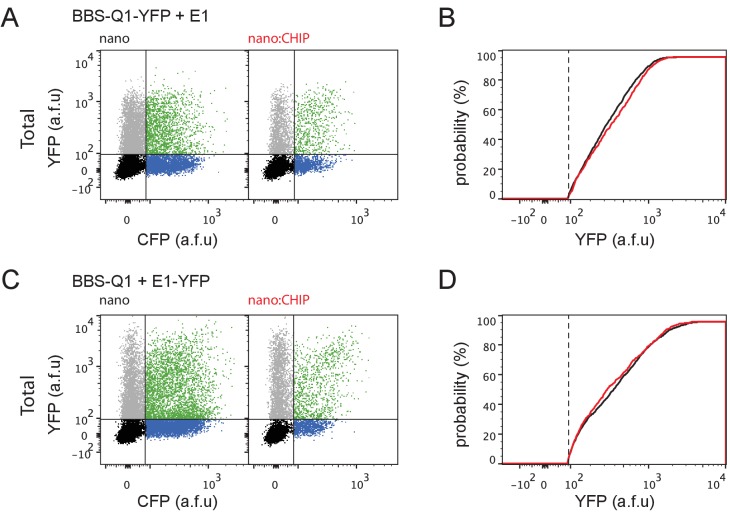
nanoCHIP has no effect on Q1/E1 total protein expression.(A) Flow cytometry analyses of total Q1 expression (YFP fluorescence) in cells expressing BBS-Q1-YFP + KCNE1 with either nanobody (left, control) or nanoCHIP (right). (B) Cumulative distribution histograms of YFP fluorescence for BBS-Q1-YFP + KCNE1 co-expressed with either nanobody (black line) or nanoCHIP (red line). (C,D) Flow cytometry analyses, and cumulative distribution histograms from cells expressing BBS-Q1 + KCNE1-YFP with either nanobody alone or nanoCHIP. Same format as (A,B).